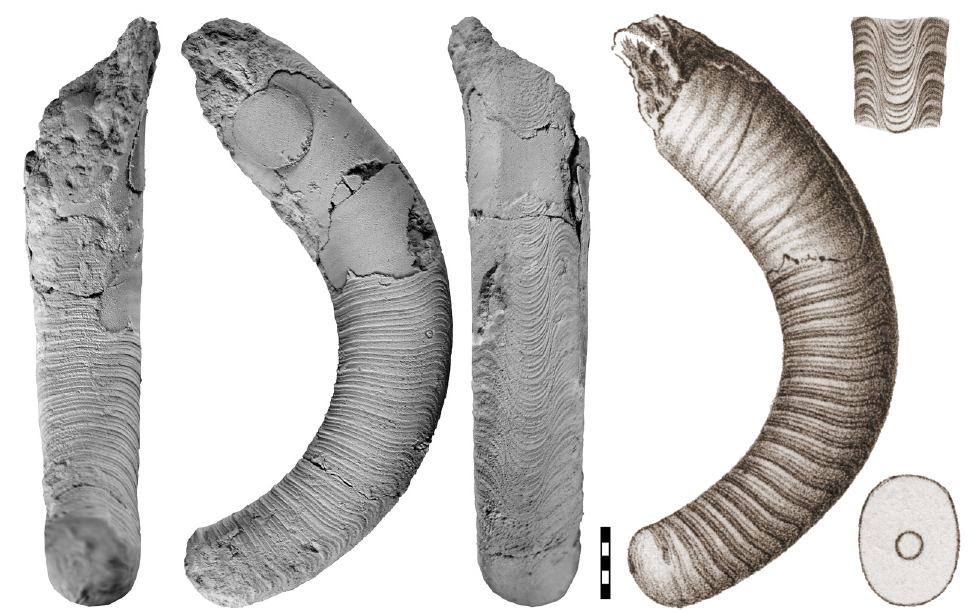
Fig. 46. Lituites fallax Remelé, 1890 from the Upper Grey Orthoceratite Limestone. Lectotype MB.C.11672.2 (Ramann, Kgl. Forstakademie Eberswalde Coll.) from Heegermühle (Brandenburg, Germany); photograph (with dorsal, lateral and ventral views) and reproduction of the illustration by Remelé (1890: pl. 5 fig. 1). Scale bar units = 1